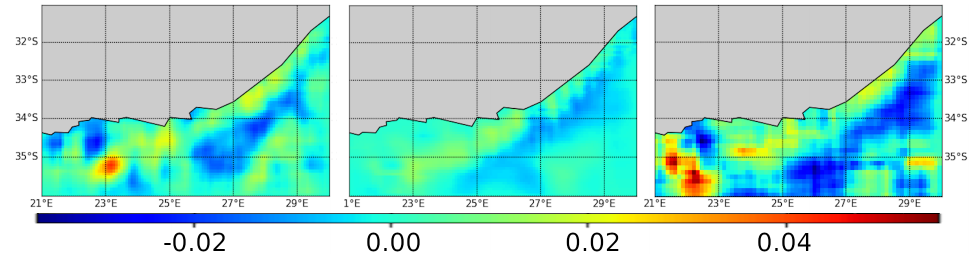
Figure 7. Mean divergence of the reconstructed velocity fields: AIS-derived current allow to retrieve divergent part of surface current. Here we compute the divergence of different current product over the first summer evaluation period. Left : proposed approach using AIS and GLORYS data during training (VAE-NODE-AIS+GLORYS). Middle : GLORYS reanalysis product. Right : the AIS-OI baseline method.